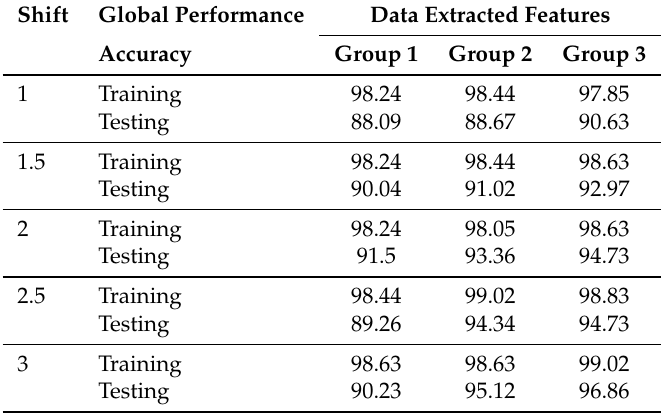
Table 5. Accuracies of extracted features based MSPCA-based SVM with different fault